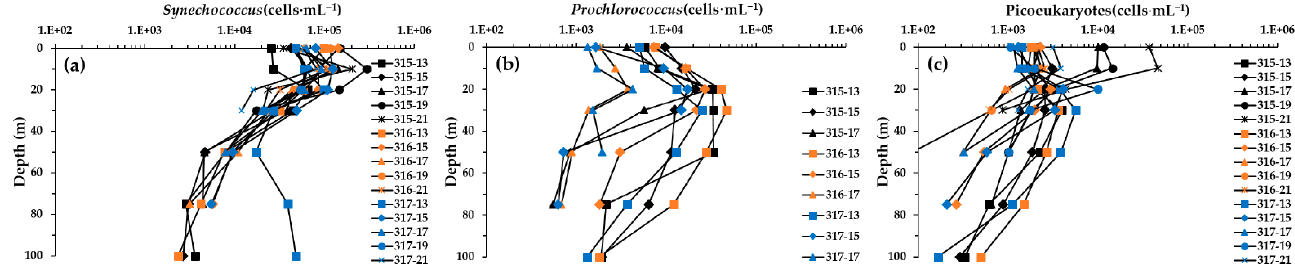
Figure 9. Vertical distributions of Synechococcus ( a ), Prochlorococcus ( b ), and picoeukaryote ( c ) cell abundances (cells·mL − 1 ) found at each station in the northern East China Sea from 2016 to 2020.